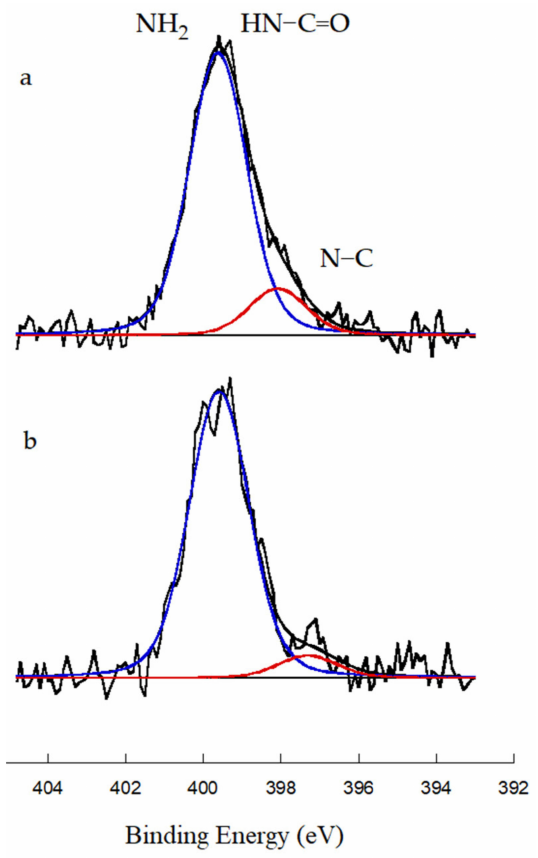
Figure 7. N1s core level normalized spectra of PMAA-G3.0-CNTs 3 ( a ) and PMAA-G3.0-CNTs 4 ( b